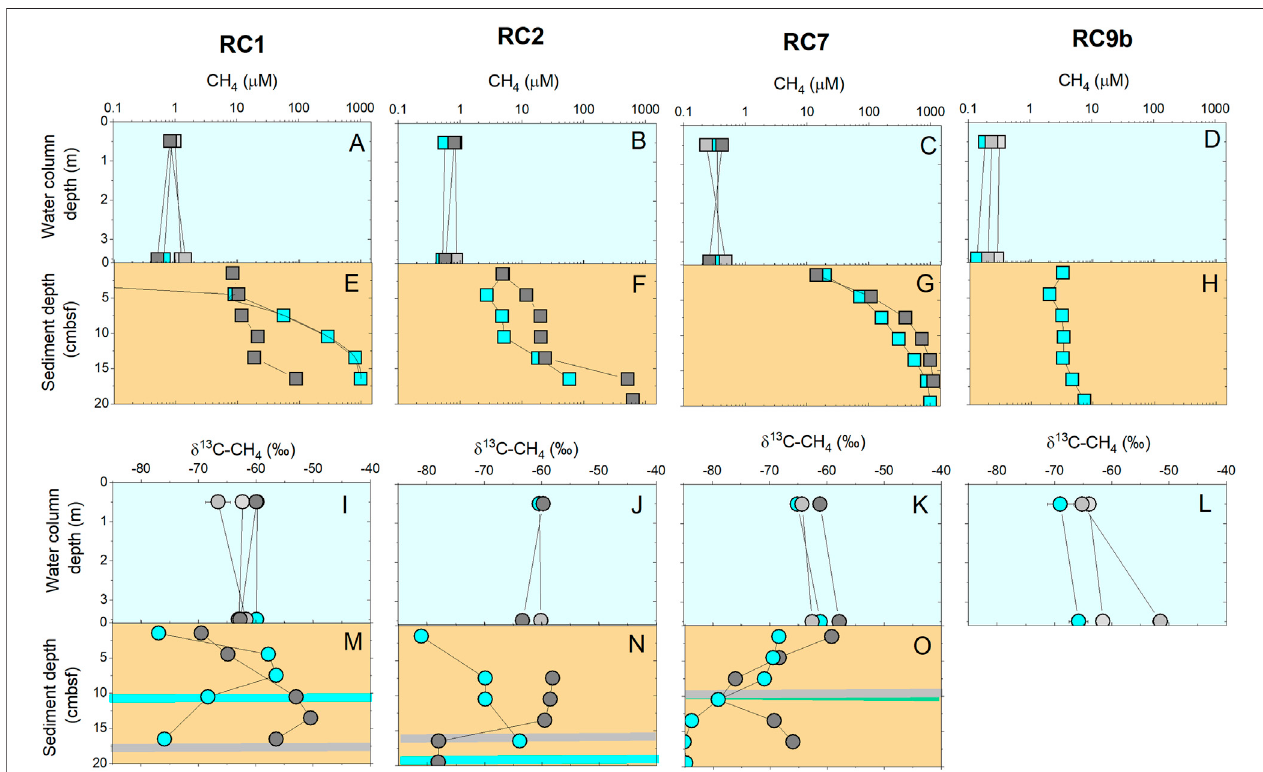
FIGURE 5 | In 2018, methane concentrations (A – H) and stable carbon isotopes (I – O) in water column (blue background) and in sediments (brown background). Bluesymbolcolordenoteswhenaeratorswereon,anddarkgraywhentheywereofffor7 days.Horizontalbarsinsediments (M – O) showsthemovementofthesulfate- methane transition zone between ON (blue color) and OFF (gray